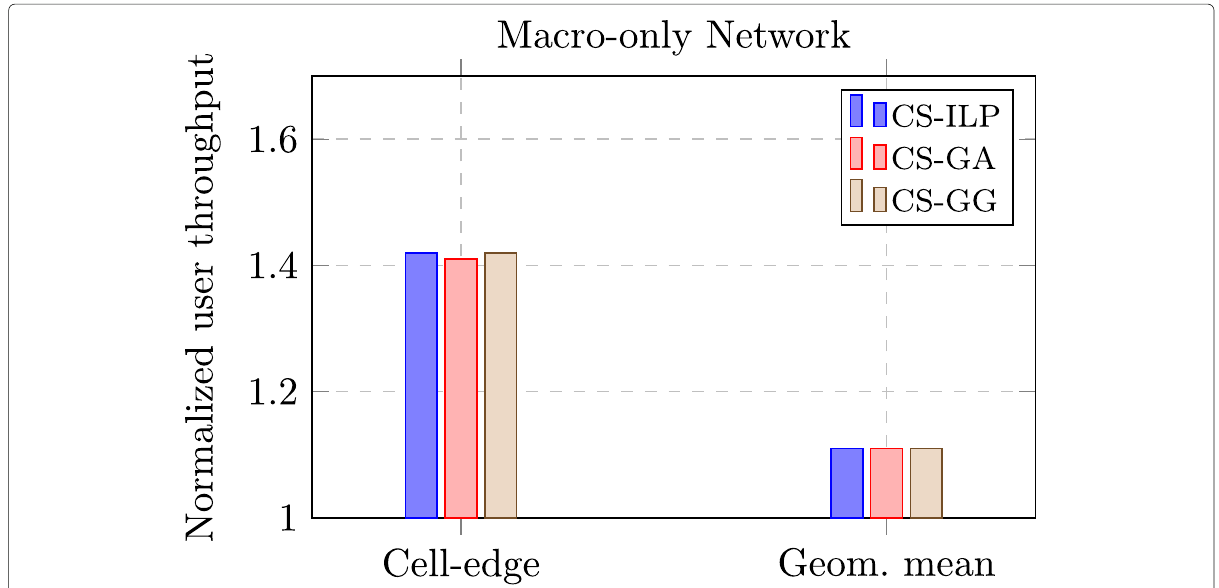
Fig. 5 Cell-edge and geometric mean of the average user throughput, normalized with respect to the non-coop. PFS, for a scenario with M = 21 BSs, N = 630 UEs, L = 10 PRBs, and M (cid:4) = 2 BSs, with wrap-around technique. Results from system level simulations of a macro-only